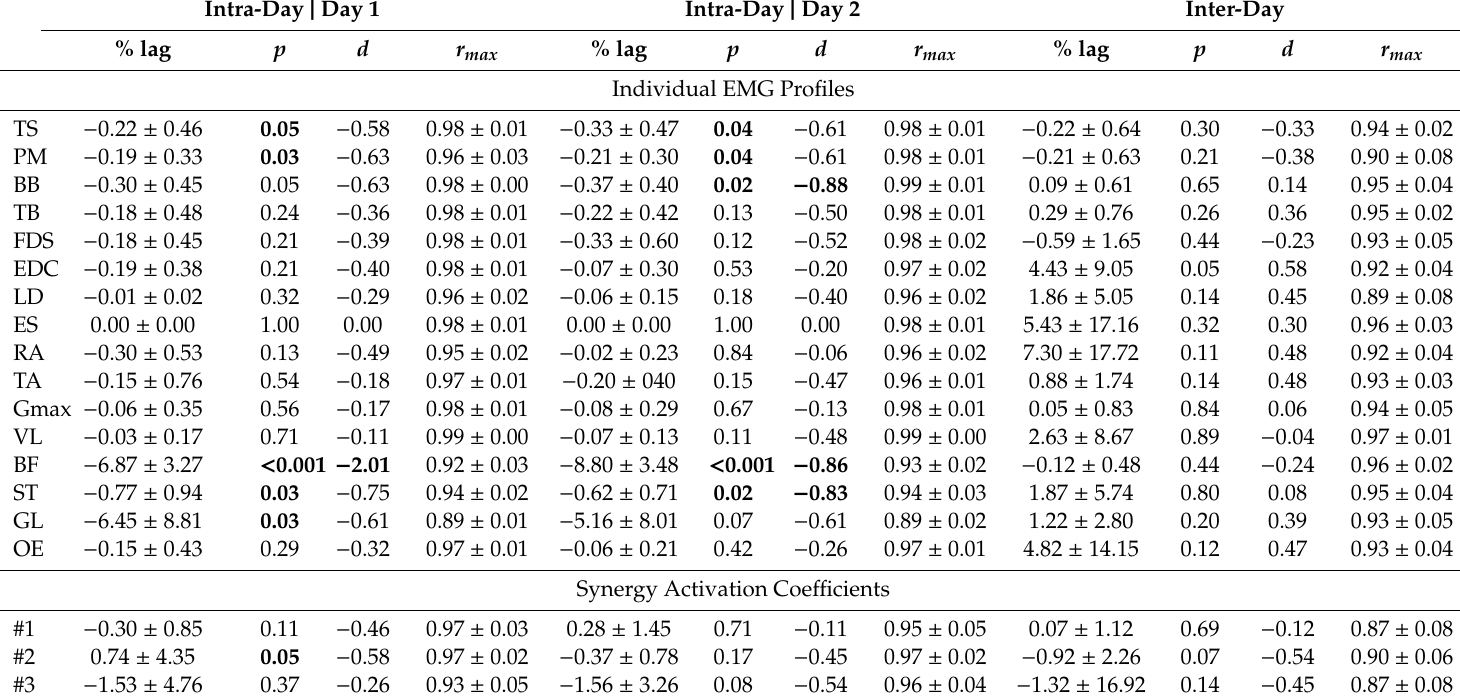
Table 2. Intra- and inter-day similarity values ( rmax ) and lag times (% of the power clean cycle) of synergy activation coe ffi cients and individual EMG profiles. Bold values represent significantly di ff erences from zero and Cohen’s d above